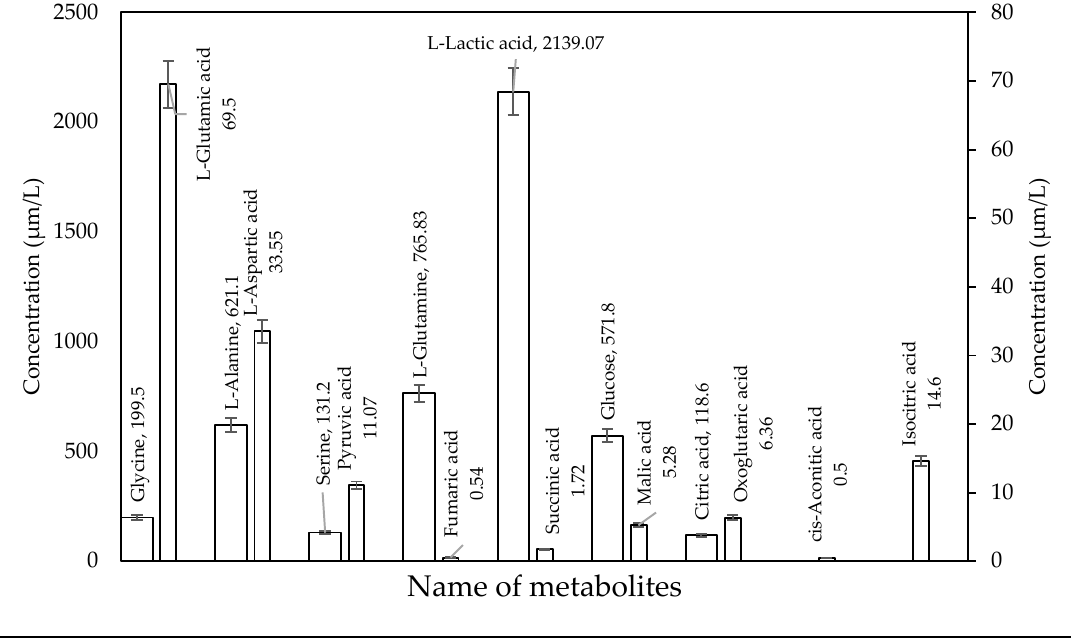
Figure 3. Measure of TCA cycle intermediates concentration in six Quality Control human serum.